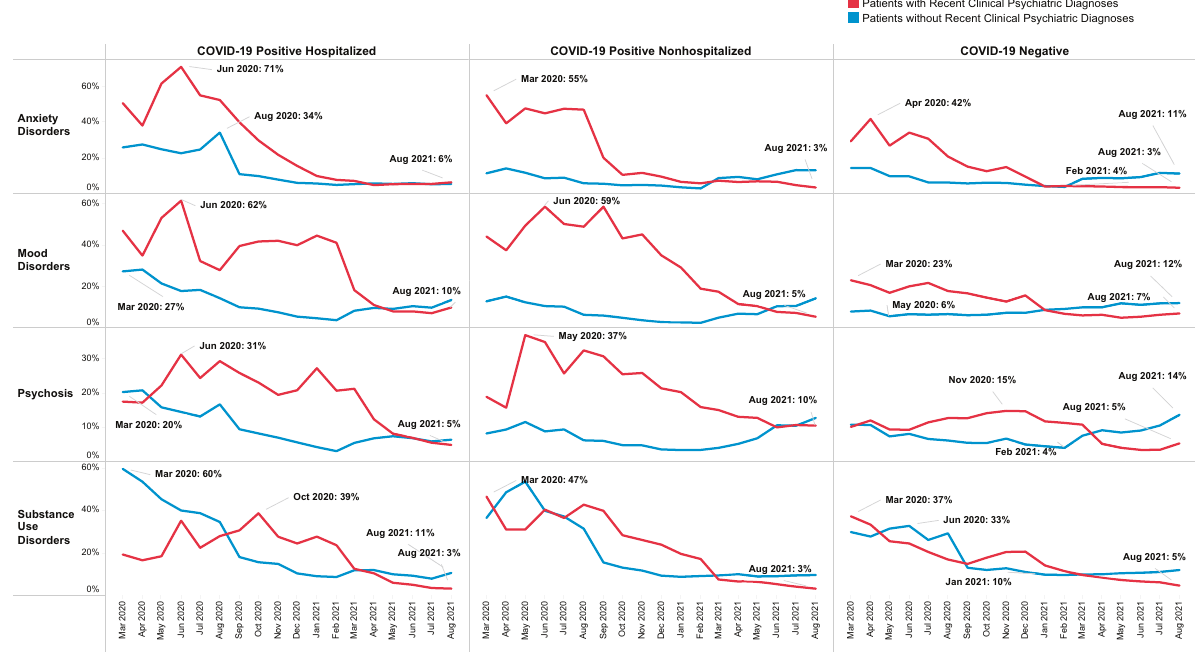
while anxiety disorders increased among COVID-19 negative patients (Fig.